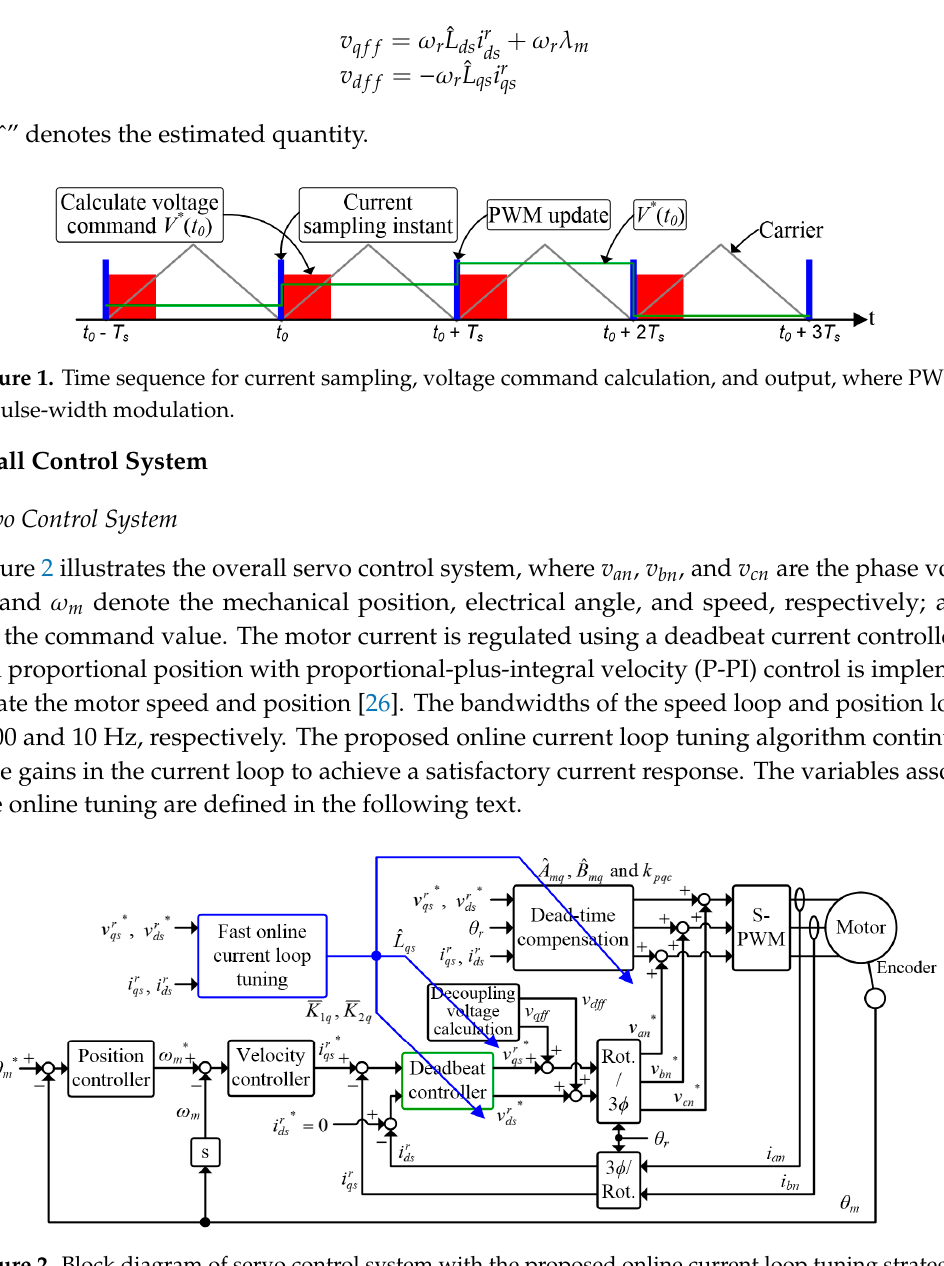
Figure 2. Block diagram of servo control system with the proposed online current loop tuning